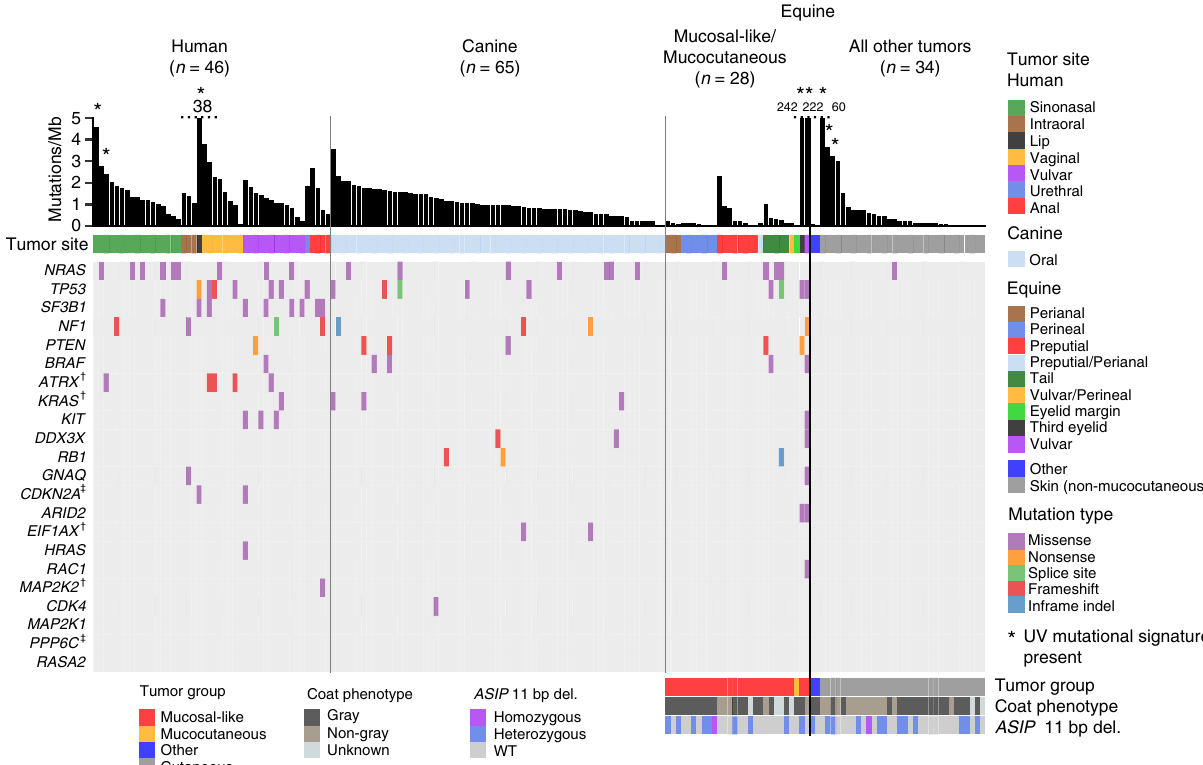
Fig. 1 Genomic landscape of primary melanomas from human, canine and equine patients. Shown are mutations in established melanoma genes curated from previous studies 6,35 , and the exome-wide somatic mutation burden, as mutations/Mb. Mutation type and tumor sites are indicated by color. Equine cases were also classi fi ed as mucocutaneous or mucosal-like. As a comparator, primary cutaneous cases and two cases from other sites are also displayed. A full summary of the cases analysed in this study is provided in Supplementary Data 1. For equine cases, gray coat color phenotype is shown, as is the presence of the germline 11 bp ASIP deletion in exon 2 70 . Dagger, the gene has not been annotated in the equine genome in Ensembl release 91. Double dagger, the gene has not been annotated in the canine genome in Ensembl release signatures were identi fi ed with high con fi dence. As mutation rates were low in the tumors not affected by UV light exposure, sequencing of additional samples and/or whole-genome sequen- cing may reveal additional known or novel signatures in mucosal melanoma.